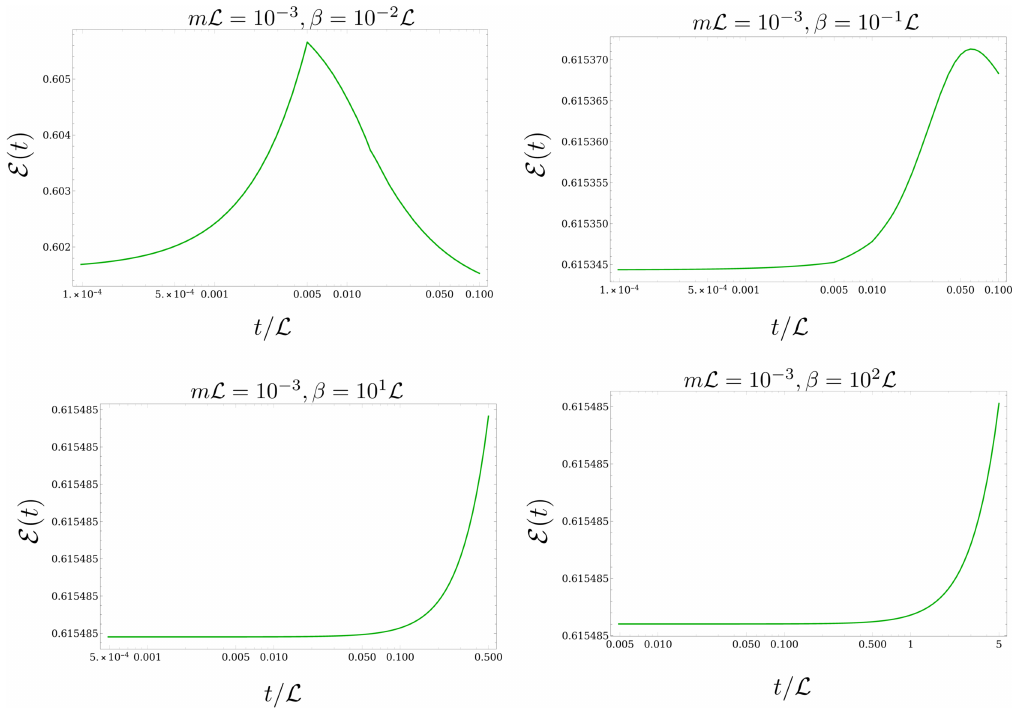
Figure 13 . Temperature effect on initial growth of logarithmic negativity E . We take N =1501